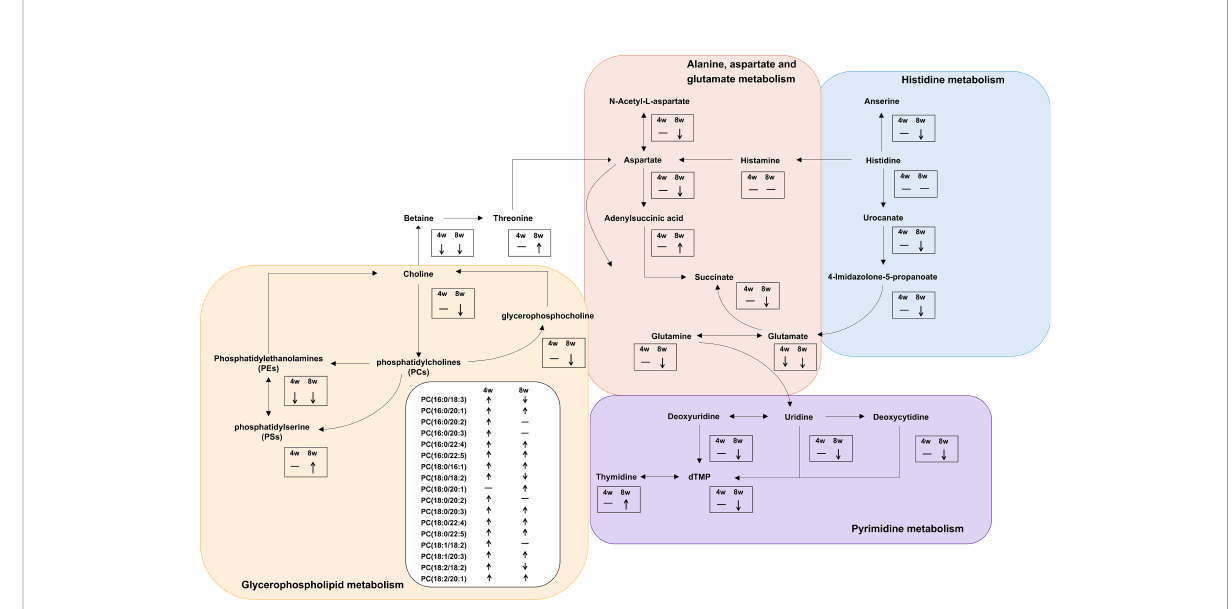
FIGURE 7 Integrated metabolic networks of signi fi cantly altered metabolic pathways during C. sinensis infection. The black arrows indicate up-regulation and down-regulation. Horizontal lines indicate that the metabolites are no